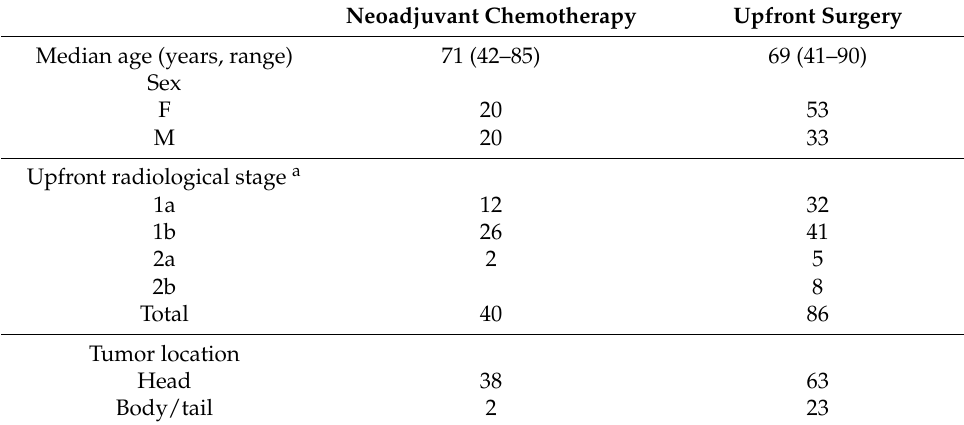
Table 1. Baseline characteristics per upfront treatment